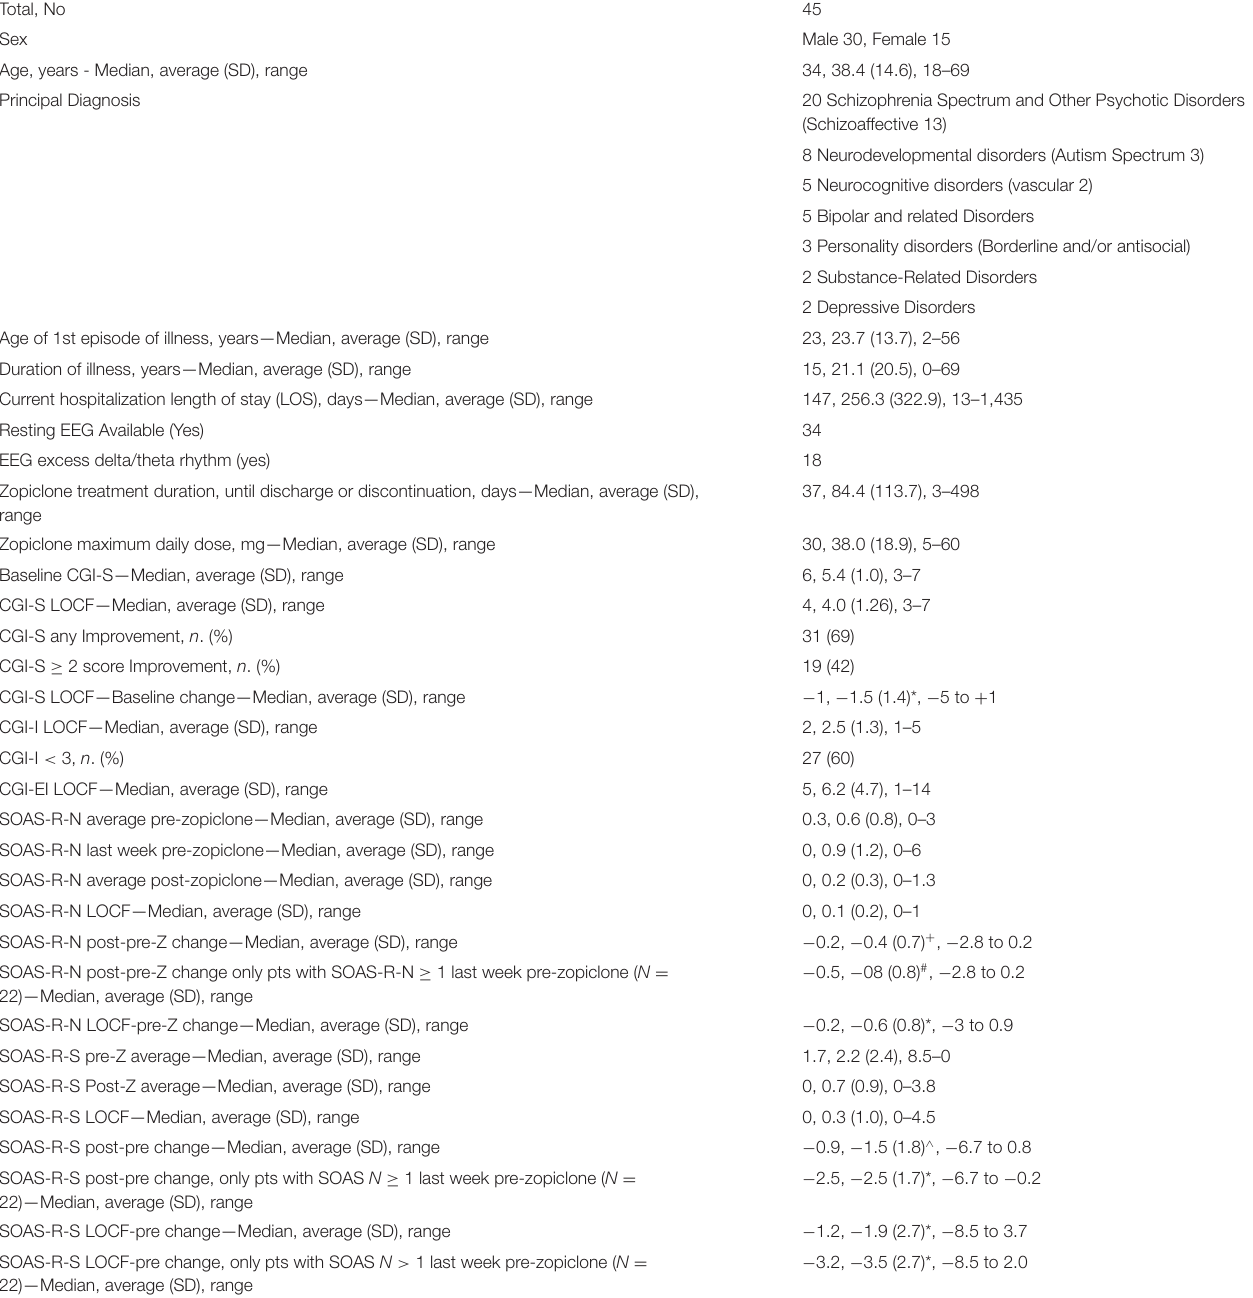
TABLE 1 | Patients’